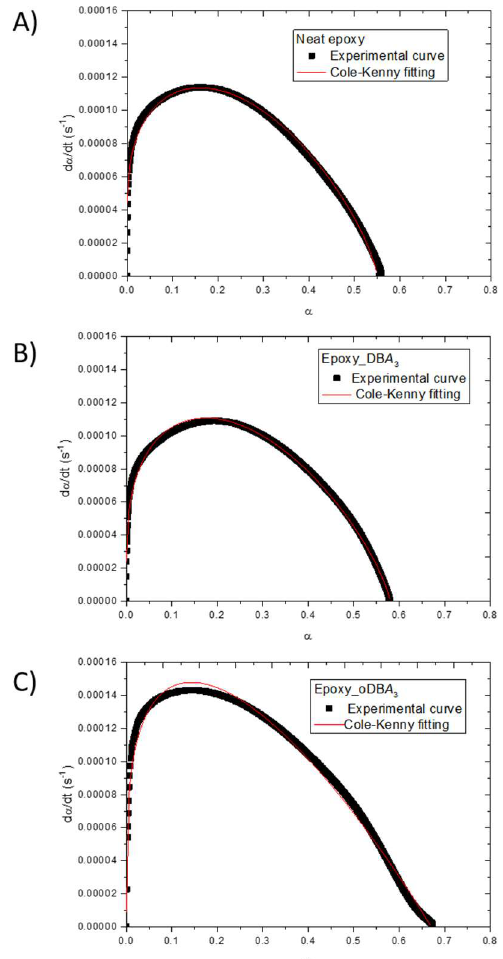
Figure 6. Comparison between the experimental curves and the Equation (2) model predictions of ( A ) neat epoxy resin and epoxy resin filled with 3 wt.% ( B ) DBA and ( C ) oDBA.